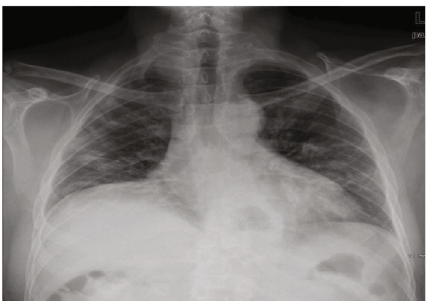
Figure 1: AP portable radiograph showing low lung volumes and patchy linear opacities in the periphery of both lungs.